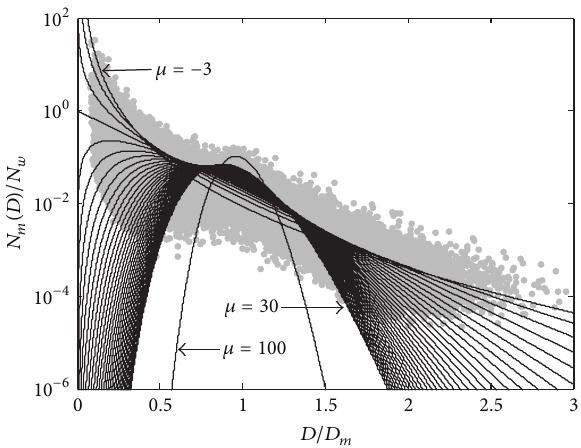
Figure 10: The scaled DSD 𝑁 𝑚 (𝐷)/𝑁 𝑤 versus normalized diameter parameter 𝐷/𝐷 𝑚 of the measured samples (gray dots). Solid lines indicate the normalized Gamma distribution for values of 𝜇 ranging between − 3 and 30 at step of 1. The curve of 𝜇 = 100 is also